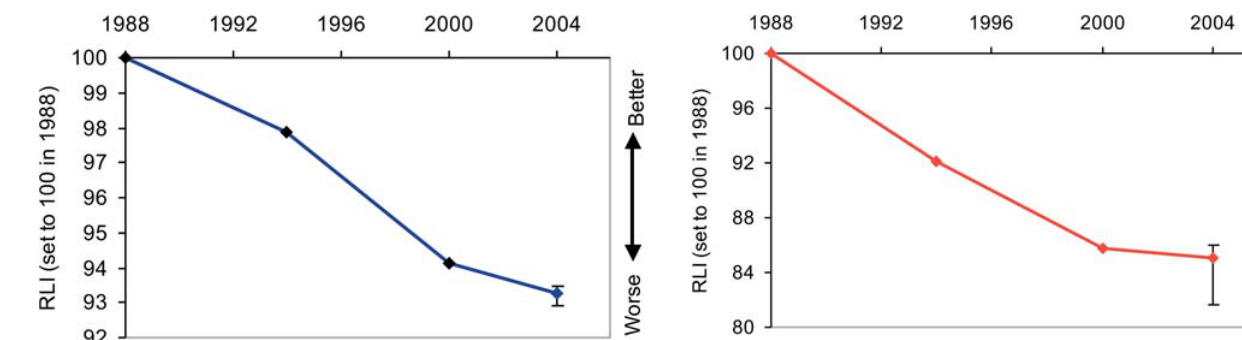
Figure 1. The RLI for All Bird Species Sample size: 250 genuine status changes/2,469 species in categories Extinct in the Wild to Near Threatened in at least one assessment. Error bars for 2004 RLI value based on estimated number of genuine status changes for 2000–2004 not yet detected owing to information time lags (see Materials and Methods for further details). DOI: 10.1371/journal.pbio.0020383.g001